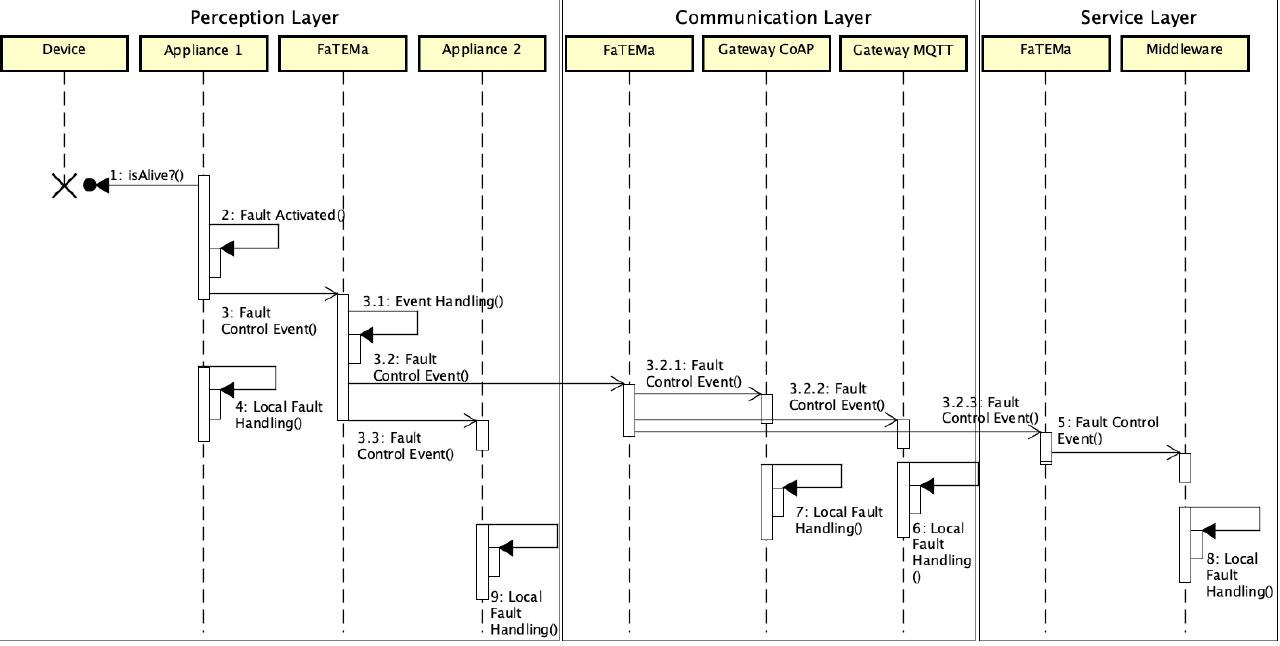
Figure 4. Communication event flow between layers in the smart building scenario.